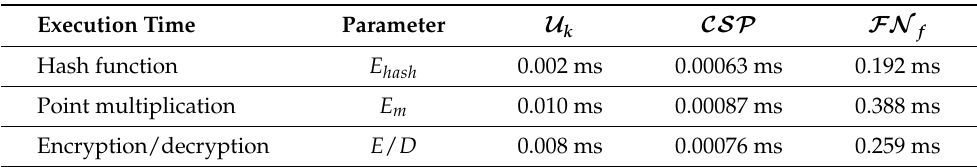
Table 4. Cryptographic Operations used for